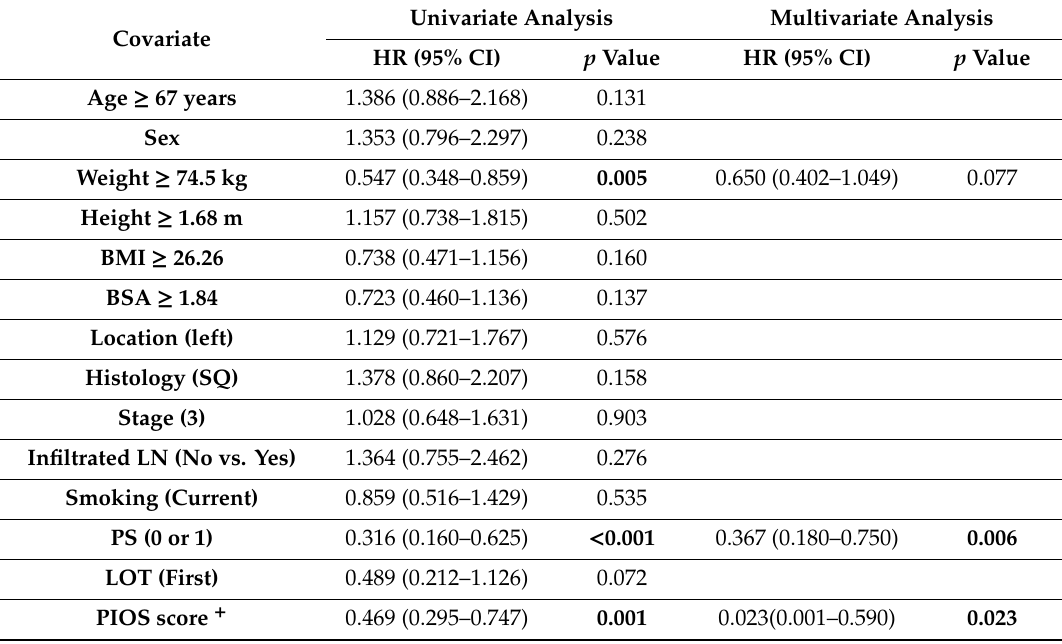
Table 2. Univariate and multivariate analysis for PFS.